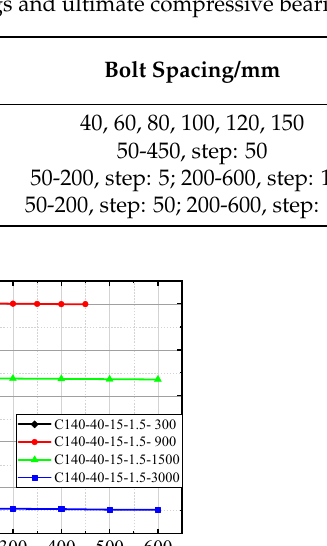
Figure 16. N u - b / t relationship curves of the combined columns.